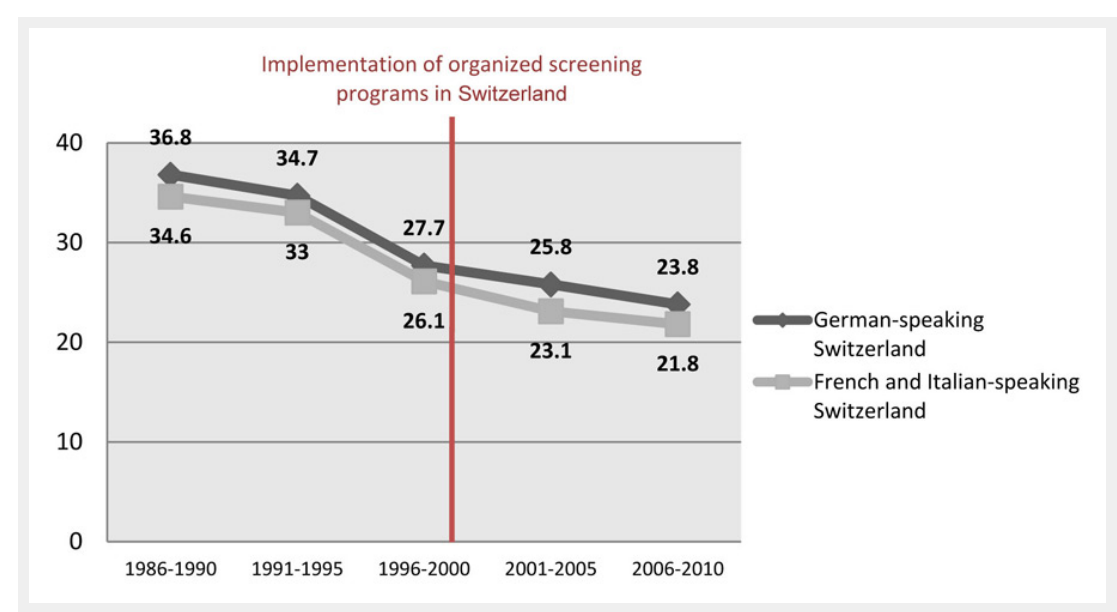
Breast cancer mortality rates by region over time (all women). Death rates per 100'000 are age standardised using the European Standard Population. The introduction of the mammography screening programme does not seem to modify the mortality rate, which had been progressively declining since 1990. Source: Swiss Federal Statistical